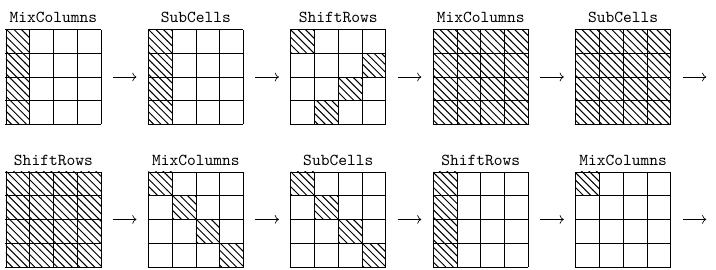
Figure 6: Linear trail with a minimal number of active S-boxes over four rounds of LED, with only one active column in the input- and output masks. The figure shows the nonzero cells in the output masks of each